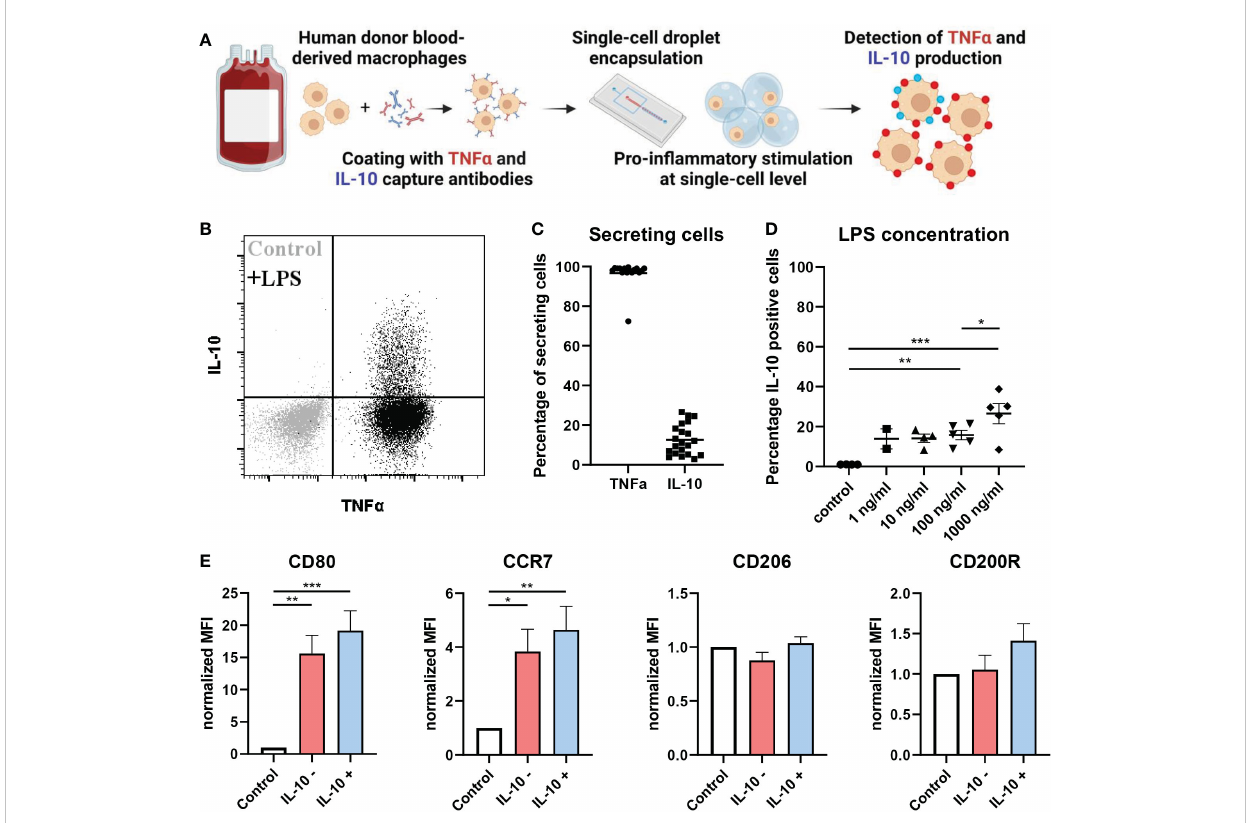
FIGURE 1 At single-cell level IL-10 is produced by a small population of macrophages. (A) Schematic of work fl ow. (B) fl ow cytometric analysis of TNF a and IL- 10 secretion by unstimulated control (grey) and LPS stimulated (black) macrophages in single-cell droplet culture from one representative donor. (C) Percentage of cells producing either TNF a or IL-10 after LPS stimulation at single-cell level (n=21 independent donors). (D) The effect of LPS concentration on fraction of IL-10 producing cells for n=2 to 5 independent donors. Signi fi cance was tested using one-way ANOVA and post-hoc Tukey test with * p<0.05, **p<0.01, and ***p<0.001. (E) Flow cytometric analysis of pro-in fl ammatory markers (CD80 and CCR7) and anti- in fl ammatory markers (CD206 and CD200R) in control condition or after LPS stimulation for both IL-10 producers and non-producers of